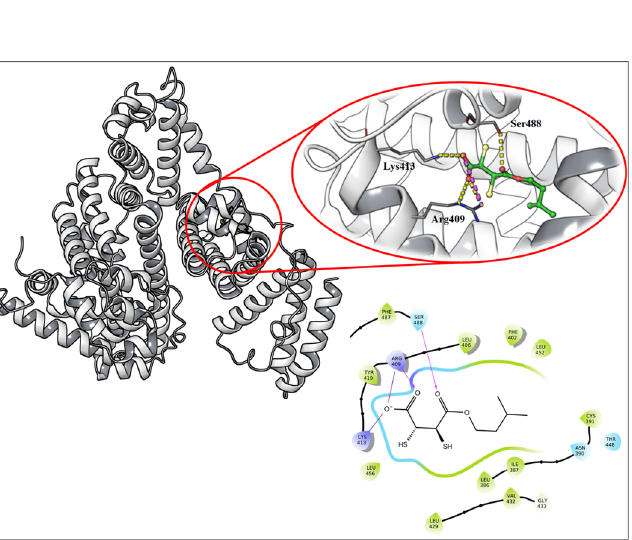
Figure 11. The docked pose of MiADMSA at ibuprofen binding site (SiteII a ) of BSA (Desmond Academic license 2018-4, https ://www.schro dinge r.com/citat ions#Desmo